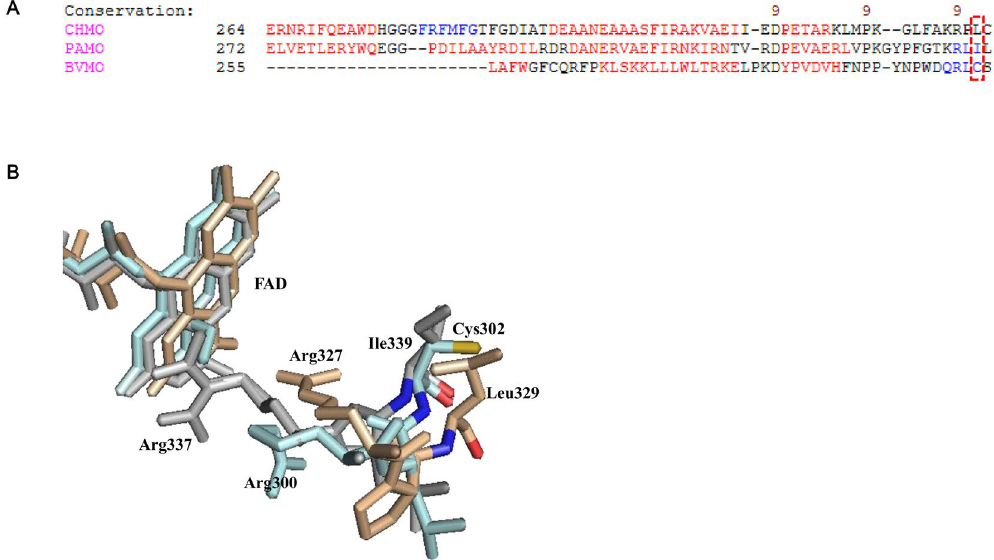
Figure 3. The sequence ( A ) and the three-dimensional structure ( B ) alignments of the BVMO of P . putida KT2440 with the phenyl acetone monooxygenase (PAMO) from Thermobifida fusca and the cyclohexanone monooxygenase (CHMO) from Rhodococcus sp. strain HI-31. The previously reported homology model of the P . putida KT2440 BVMO 15 and the crystal structures of the PAMO (PDB code 1W4X) and the CHMO (PDB code 3GWD and 3GWF) were used for the study. The cyan, grey and yellow colors indicated the structure of P . putida KT2440 BVMO, PAMO, and CHMO, respectively.